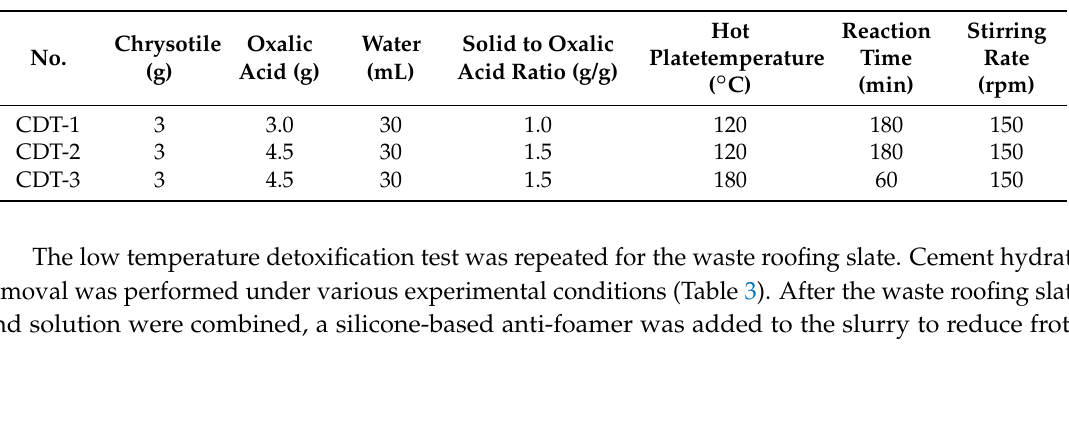
Table 2. Experiment condition of low temperature detoxification